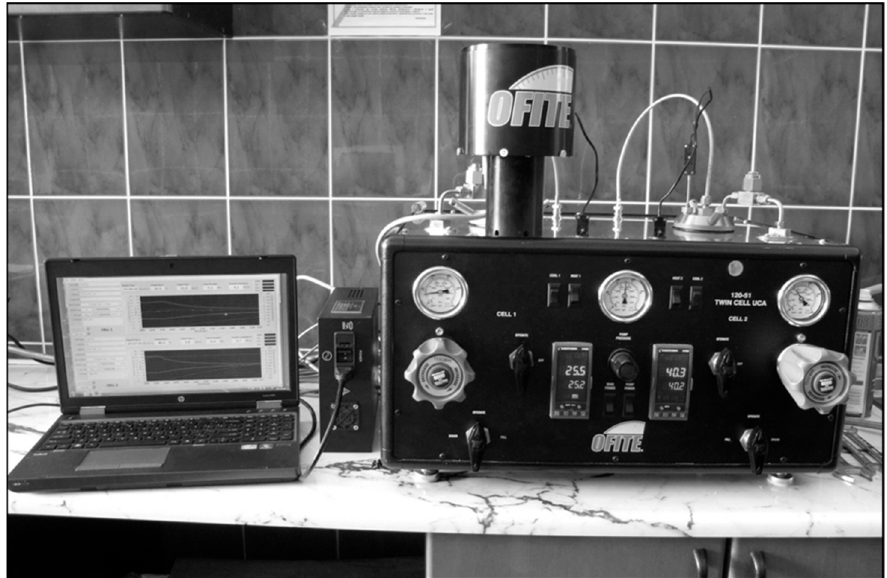
Figure 6. Apparatus for testing the build-up of static structural strength in slurry—two-chamber UCA SGSM Ofite model 120-53.